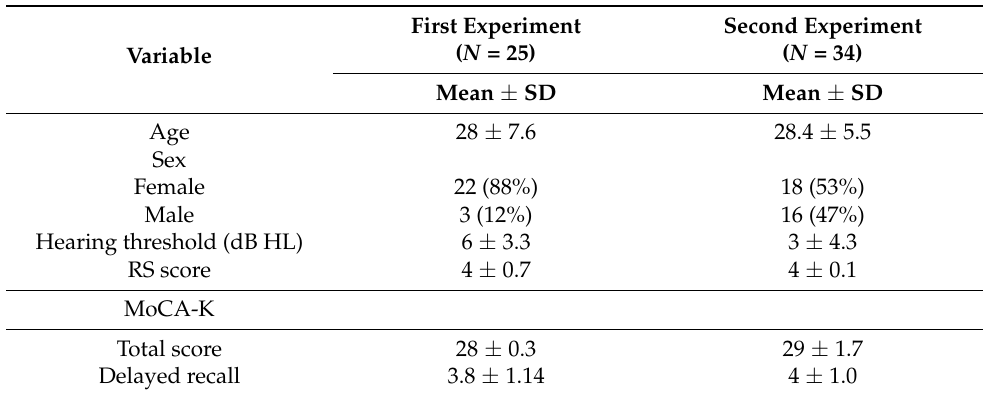
Table 1. Demographics of all participants. Variable